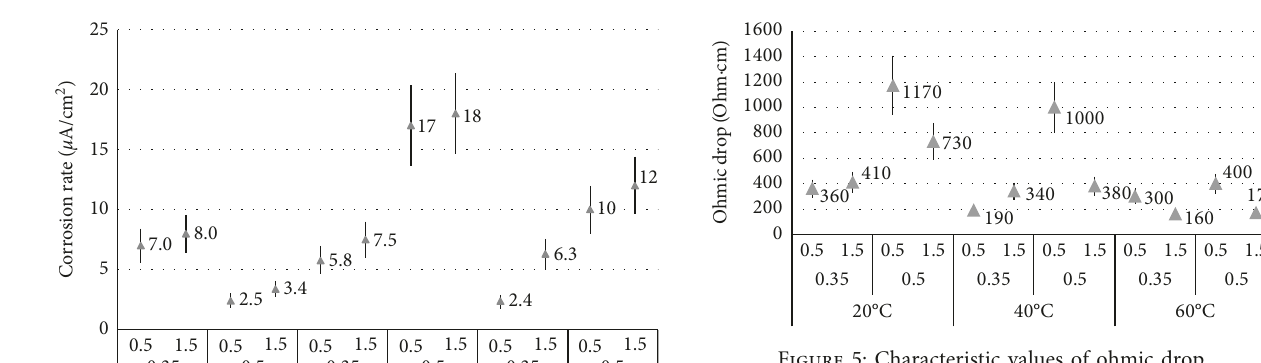
Figure 5: Characteristic values of ohmic